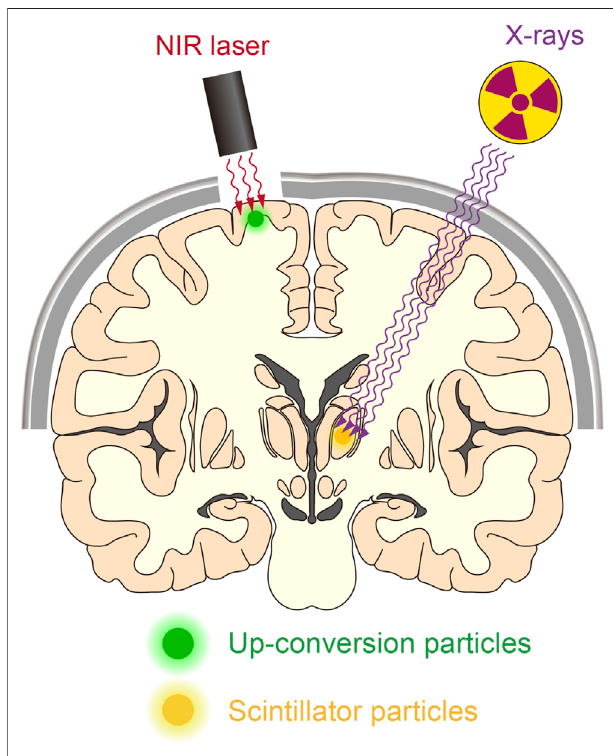
FIGURE 3 | Manipulating deep neurons by remote optogenetics. With technologicaladvances,itmightbepossibletoopticallymanipulateneuronsin the human brain. This could aid the treatment of patients with various neurological disorders such as Parkinson ’ s disease and epilepsy. NIR- mediated up-conversion optogenetics may be applied for neuronal actuation in the cortical regions, whereas X-ray-mediated down-conversion optogenetics is not constrained by tissue